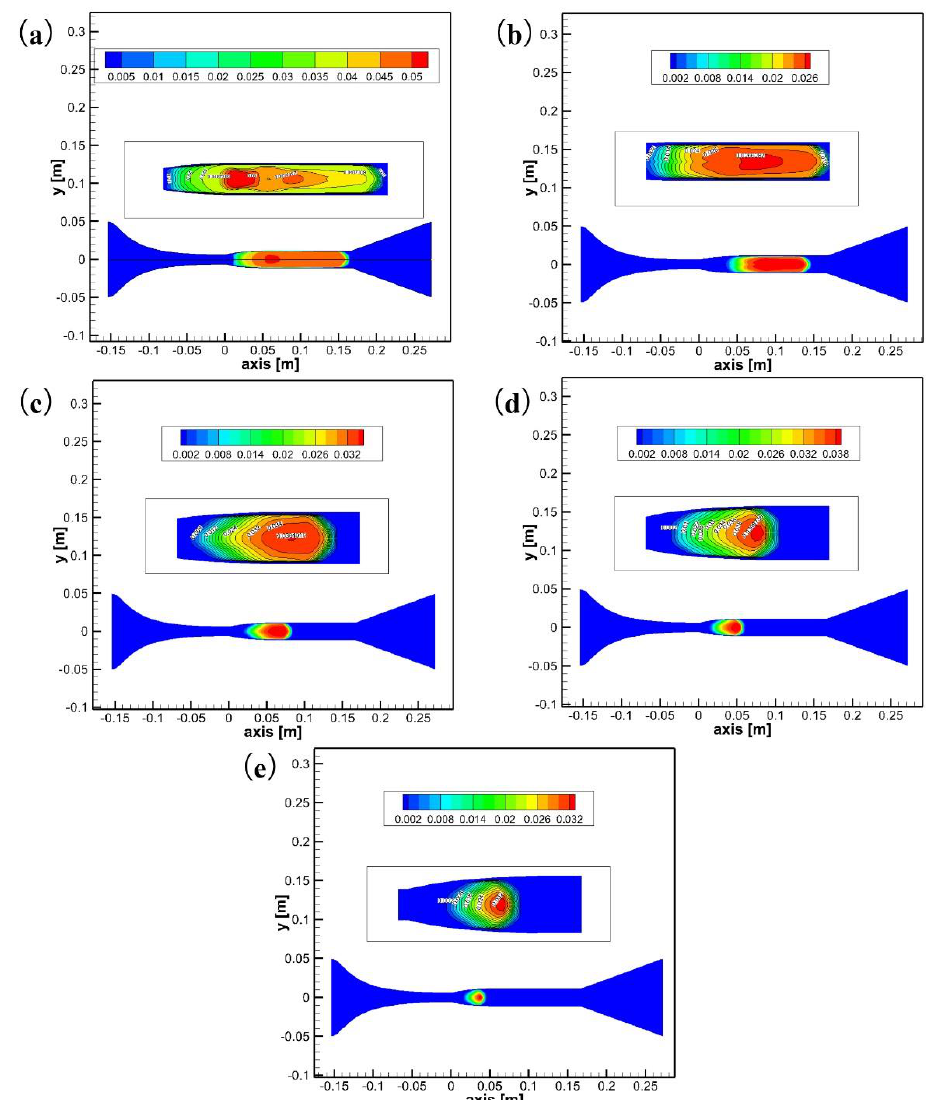
Figure 11. Humidity distribution along the axial cross-section of the supersonic separator at export back pressure values ( a ) 1.6 MPa; ( b ) 1.8 MPa; ( c ) 2.2 MPa; ( d ) 2.3 MPa, and ( e ) 2.4 MPa.